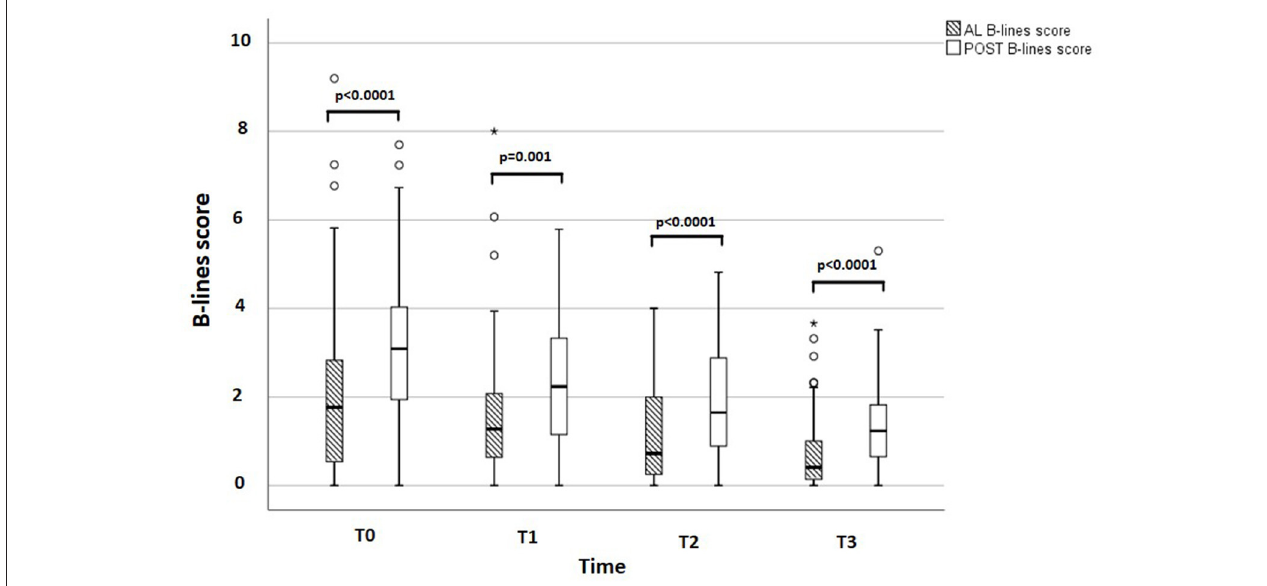
FIGURE 3 | AL and POST B-lines score at each time point. Box and whisker graph describing AL and POST B-lines score at each time point. AL, antero-lateral; POST, posterior.